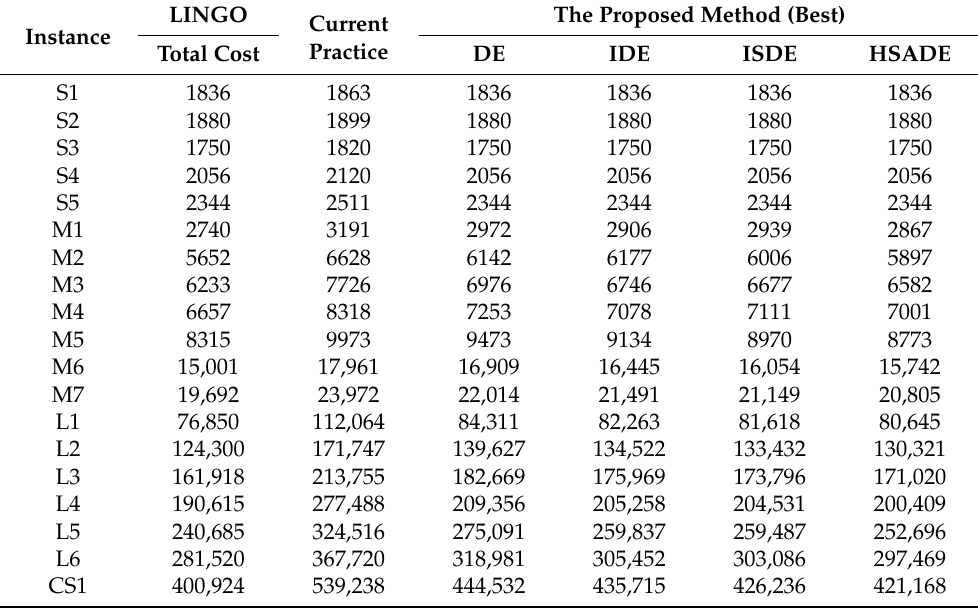
Table 4. Computational results showing the total cost.